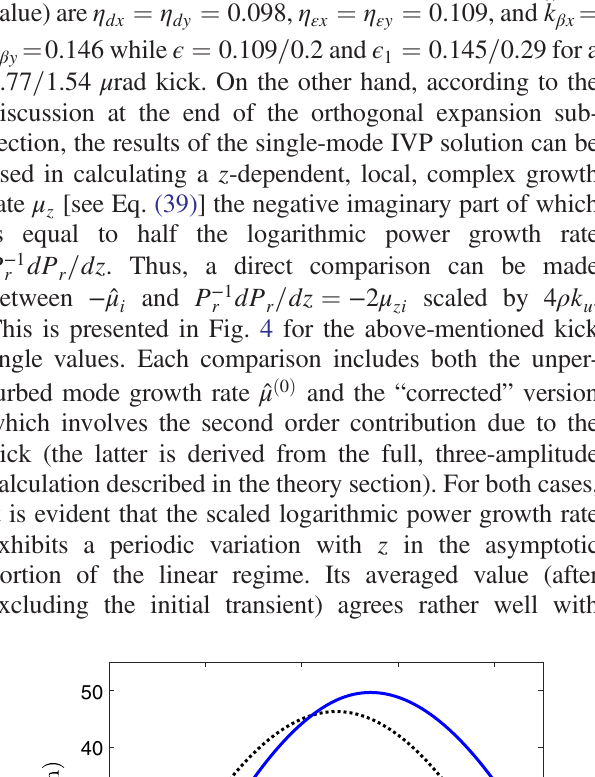
FIG. 1. Electron beam centroid, FEL gain and bunching factor as functions of z , for a kick angle of p 0 ¼ 0 = 0 . 77 = 1 . 54 = 2 . 31 μ rad (blue/red/green/magenta). The solid and dashed lines represent the linearized solution and GENESIS simulation results, respectively.